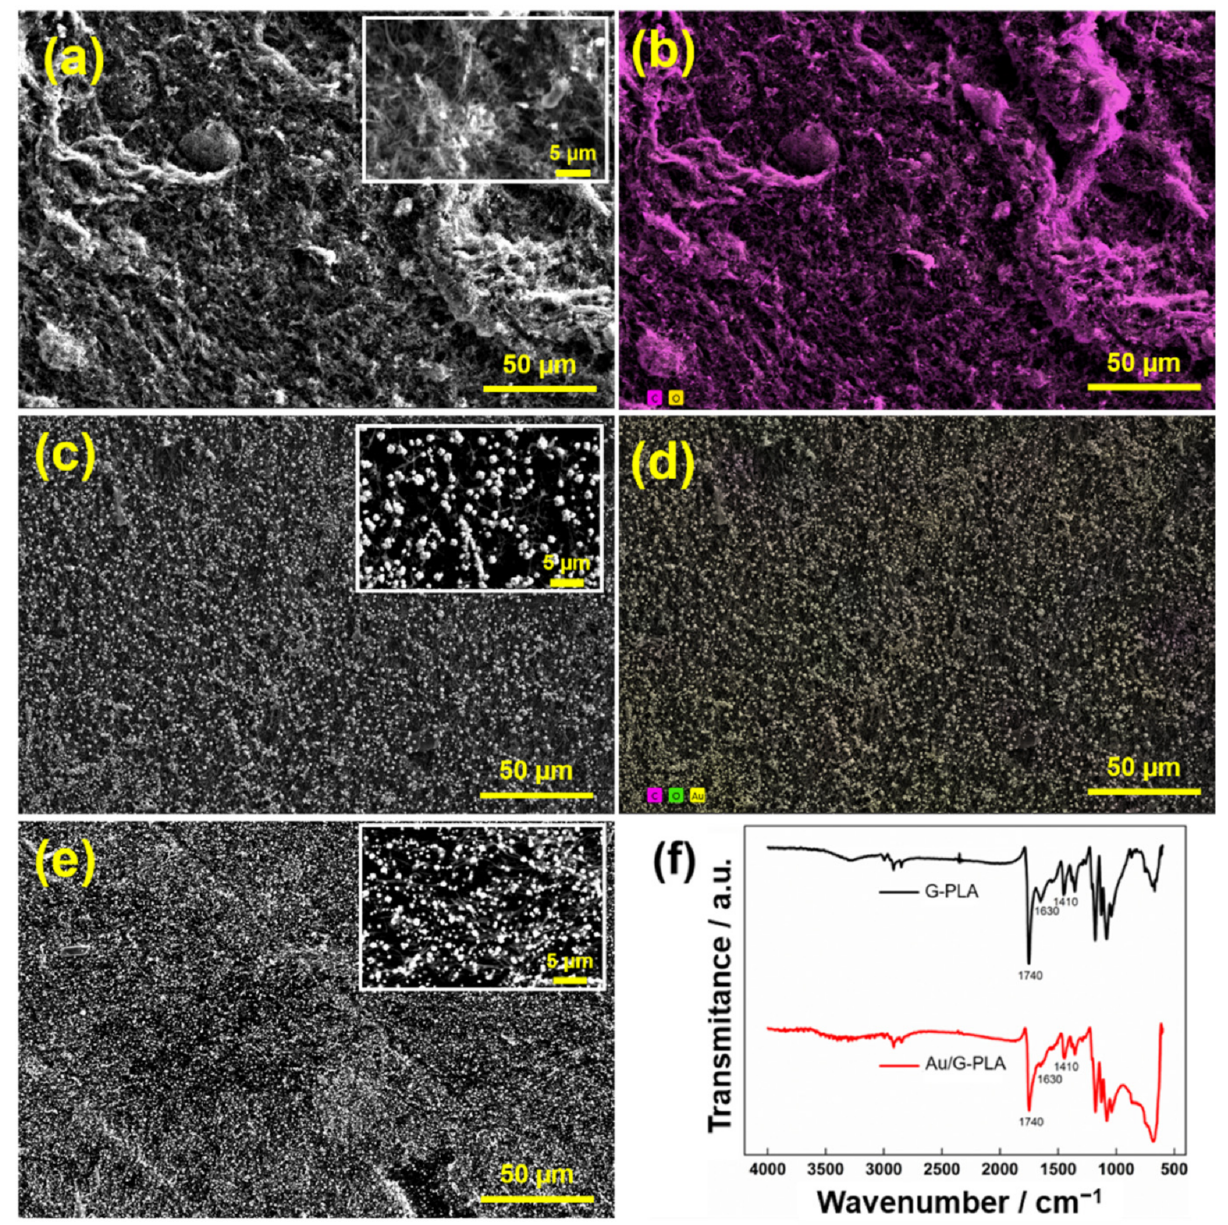
Figure 1. SEM images of electrode surfaces ( a ) G-PLA, ( b ) corresponding element mapping of G-PLA, ( c ) Au/G-PLA (400 s deposition), ( d ) corresponding element mapping of Au/G-PLA, ( e ) Au/G-PLA (250 s deposition), and ( f ) FT-IR spectra of G-PLA (black) and Au/G-PLA (red) were recorded within the wavenumber range of 600 to 4000 cm − 1